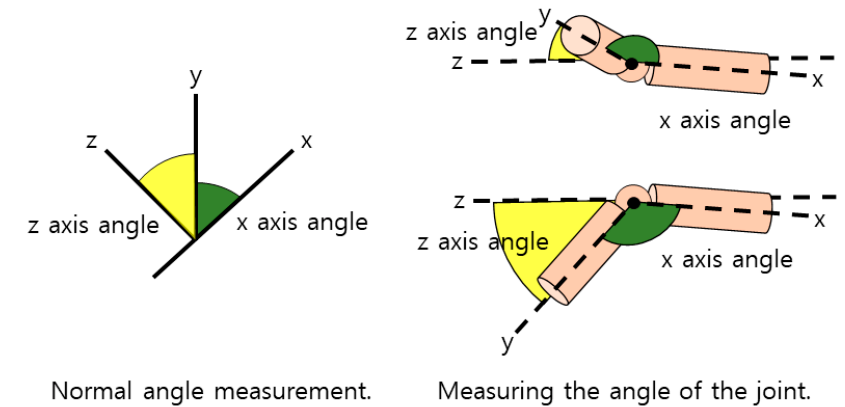
Figure 4. Image of how to measure joint angles and general methods.